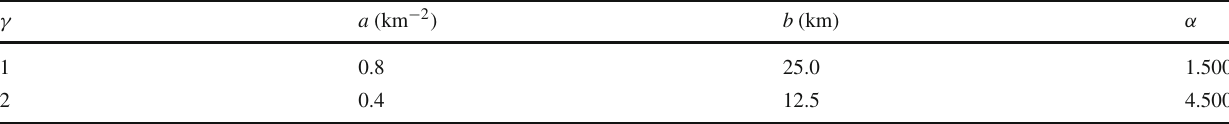
Table 6 The numerical data on the constraints for α corresponding to model #2 obtained by fixing the numerical values depicted in Table 5 α -Constraints at the wormhole throat